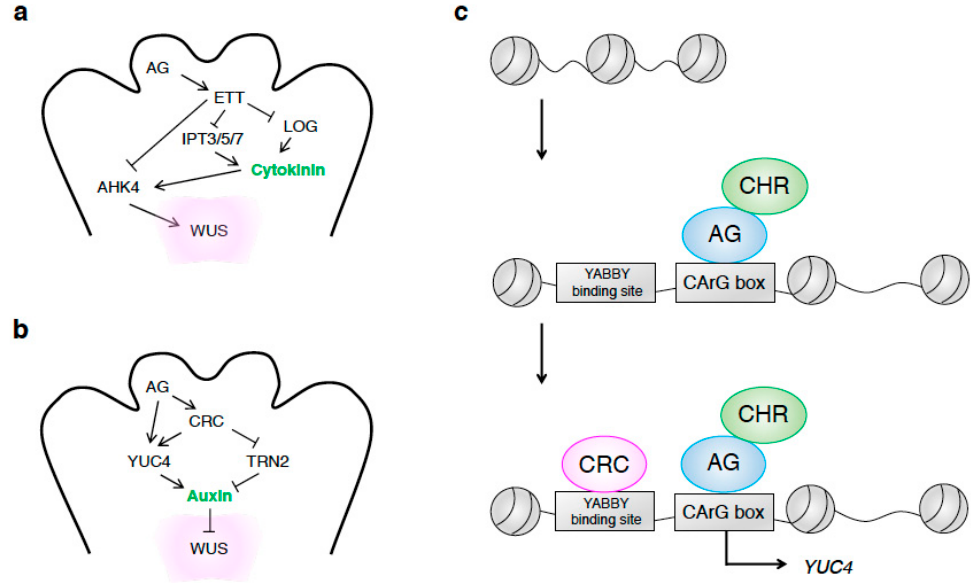
Figure 3. Hormonal control of the termination of floral meristematic fate. ( a ) Cytokinin-mediated meristematic fate termination in the FM at stage 6 of flower development. ( b ) Auxin-mediated primordium fate specification in the FM. The terminating OC is shown in pale pink. The arrows represent the activation of gene expression, while the flat arrows represent its repression. ( c ) Chromatin state switch for termination of floral meristematic fate by CRC and the AG complex. The arrow represents the activation of gene expression.